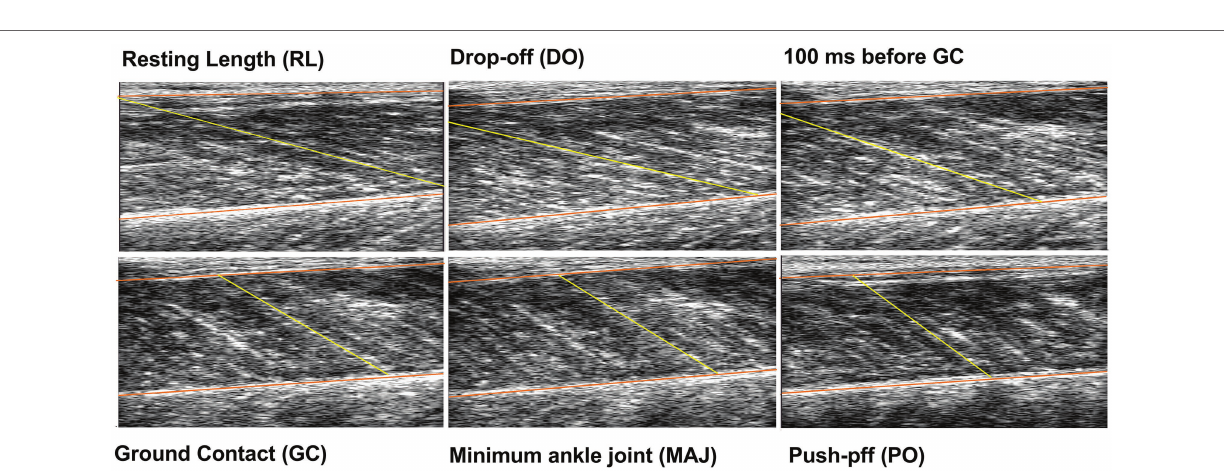
FIGURE 4 | Ultrasound images extrapolated from the video recorded during a drop jump (DJ) from a representative subject. The chosen jump time points are represented: resting length (RL; the participant being bipedally standing on the platform with 0 ° of ankle and knee flexion), drop-off (DO; 12 ms before starting to fall), 100 ms before ground contact (GC; during pre-activation), GC (beginning of the braking phase), minimum ankle joint angle (MAJ; end of the braking phase), and push-off (PO; representing the last frame before the ground is left and the flight phase is entered). One of the three analyzed fascicles and the superficial and deep aponeuroses have been superimposed to the images in yellow and orange,